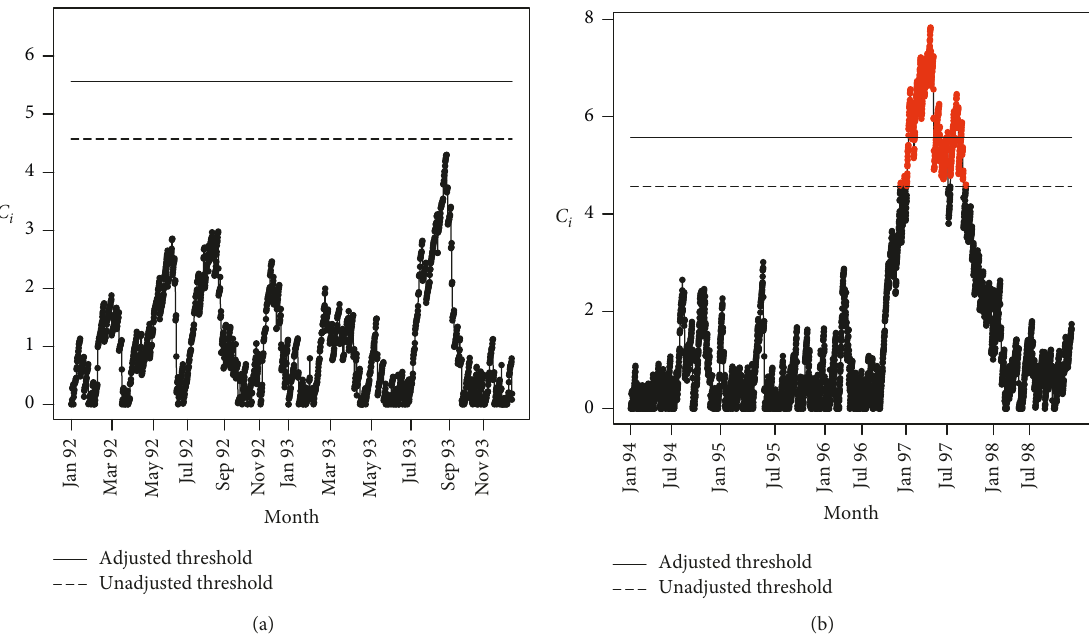
Figure 8: RA-CUSUM chart for Phase-I and Phase-II assuming first two years as the Phase-I for 30 days mortality of cardiac surgery patients. (a) Phase-I chart, unadjusted UCL � 4.57 and adjusted UCL � 5.575. (b) Phase-II chart, unadjusted UCL � 4.57 and adjusted UCL � 5.575.